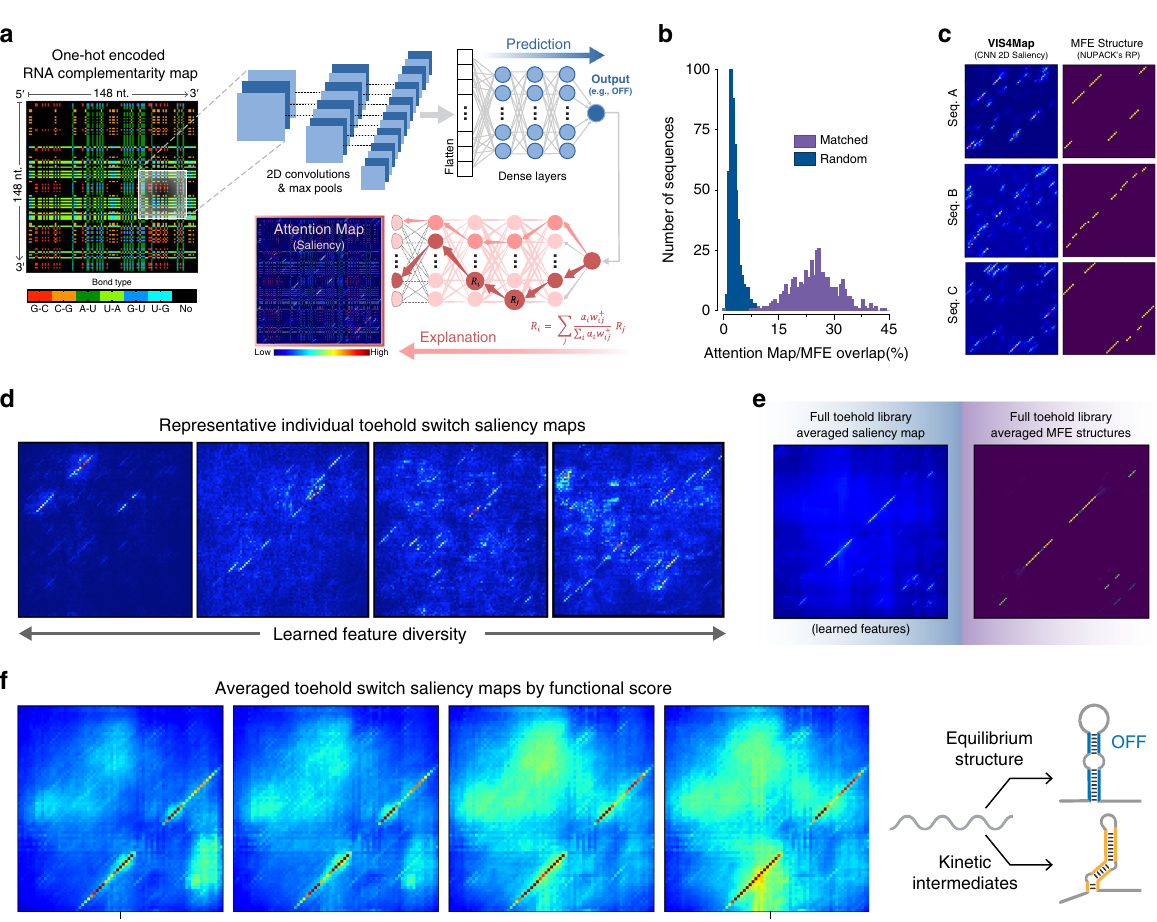
Fig. 5 VIS4Map: visualizing learned secondary structures with complementarity matrices. a A simpli fi ed schematic of the convolutional neural networks (CNN)-based architecture used to generate toehold functional predictions with network attention visualizations. The system receives a one-hot encoded, two-dimensional (2D) sequence complementarity map as input, followed by three 2D convolutional/max-pooling layers, a fl attening step, and fi nally a set of dense layers. After output generation (e.g., OFF), a gradient-weighted activation mapping is performed to visualize activation maximization regions responsible for delivered predictions (VIS4Map). b Histograms of the percentage overlap between VIS4Maps generated from a CNN pre-trained to predict minimum free energy (MFE) using 120-nt RNA sequences and MFE maps generated by NUPACK. When analyzed using 500 random test-set sequences, the distributions of correctly matched and randomly assigned maps are distinct with increased percentage overlap from matched samples as compared to unmatched. c Examples of saliency VIS4Maps compared with their corresponding MFE structures as predicted by NUPACK for three randomly selected 60-nt RNA sequences. See Supplementary Fig. 11A for additional examples with 120-nt RNA sequences. d Four representative VIS4Map examples of randomly selected 118-nt RNA toehold-switch sequences from an OFF-predictive CNN model. e Averaged VIS4Maps of 10,125 randomly selected toehold- switch RNA sequences from our library test set processed with our OFF-predicting CNN model (left) and compared their corresponding averaged MFE maps obtained using NUPACK (right). f Averaged VIS4Maps of the 10% most accurately predicted switches sorted by quartile from lowest OFF (tight) to highest OFF (leaky); inset for the toehold and the hairpin stem. After contrast enhancement of averaged VIS4Maps to visualize sparsely distributed secondary structures, a noticeable increase in structures outside of the prominent equilibrium-designed switch hairpin structure appears to correlate with increased toehold leakiness. A toehold-switch schematic (right) is shown to denote how incorrectly folded and potentially weaker kinetically stable intermediate structures might compete with the correctly folded structure that is designed to be reached at equilibrium. All source data are provided as a Source Data fi